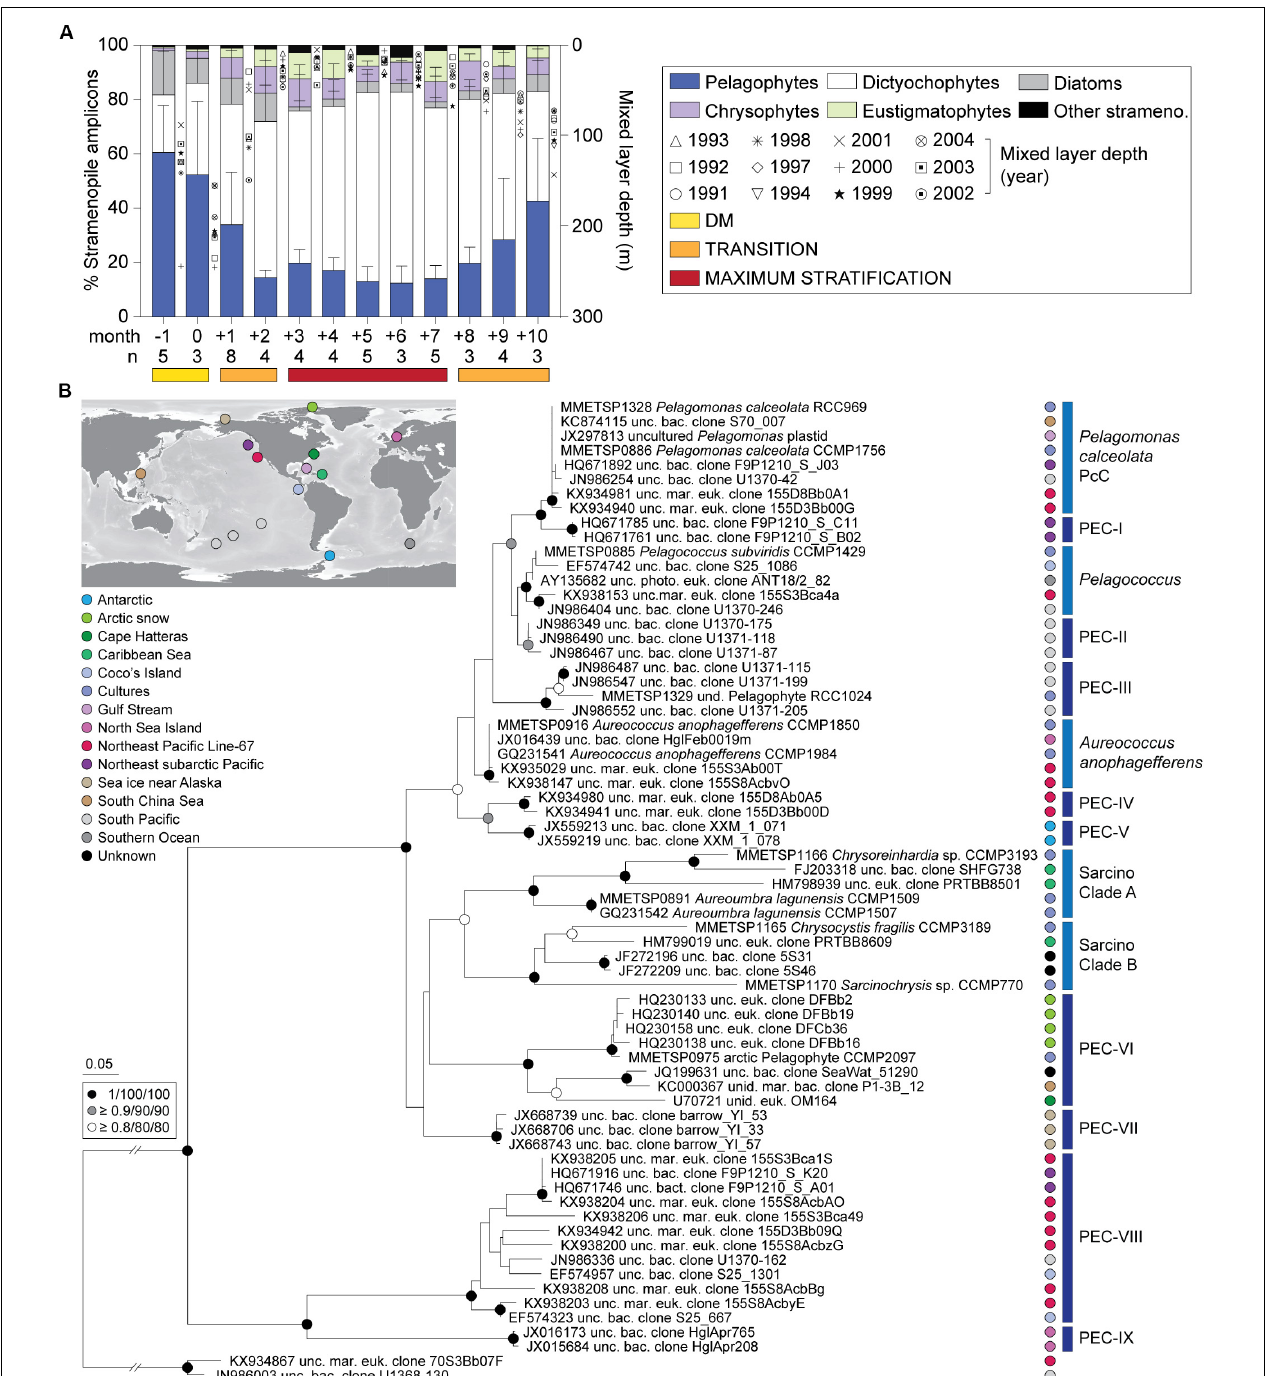
FIGURE 2 | Photosynthetic stramenopile class distributions in the northwestern Sargasso Sea and reference trees for finer-scale analyses. (A) Photosynthetic stramenopile distributions expressed as a percentage of amplicons phylogenetically assigned to stramenopile classes at BATS surface (0.3–7.6 m). Error bars represent the standard deviation and ‘n’ indicates the number of samples used for the analysis. Phylogenetic reference trees were developed to then resolve clades within the (B) pelagophytes and dictyochophytes ( Supplementary Figure S5 ) using near full-length 16S rRNA gene sequences. For pelagophytes, sequences came from nine cultured species, 56 environmental clones and two dictyochophyte sequences as an outgroup. The tree was constructed with Maximum Likelihood inference (RAxML) under the gamma corrected GTR model of evolution with 1,000 bootstrap replicates. Additional phylogenetic reconstructions were performed with PhyML and MrBayes and the node statistical supports are indicated. Five known clades were resolved and previously unrecognized nine additional clades were identified Pelagophyte Environmental Clades I-IX (PEC-I to PEC-IX). These were primarily comprised of environmental sequences. Colors indicate oceanic region of